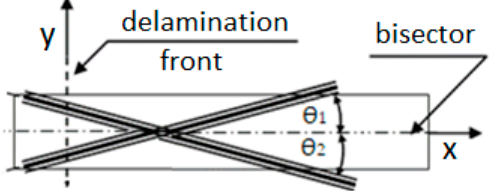
Figure 2. Arrangement of the reinforcement in the adjacent layers undergoing separation due to the delamination propagation. Relative orientation θ = θ 1 + θ 2 ( θ 1 = θ 2 ) is referred to as interfacial ply orientation. Angles θ 1 and θ 2 can be measured relative to the specimen x -axis. The θ 1 can be considered as an angle of reinforcement below the delamination plane, and θ 2 can be considered as an angle of reinforcement above the delamination plane.